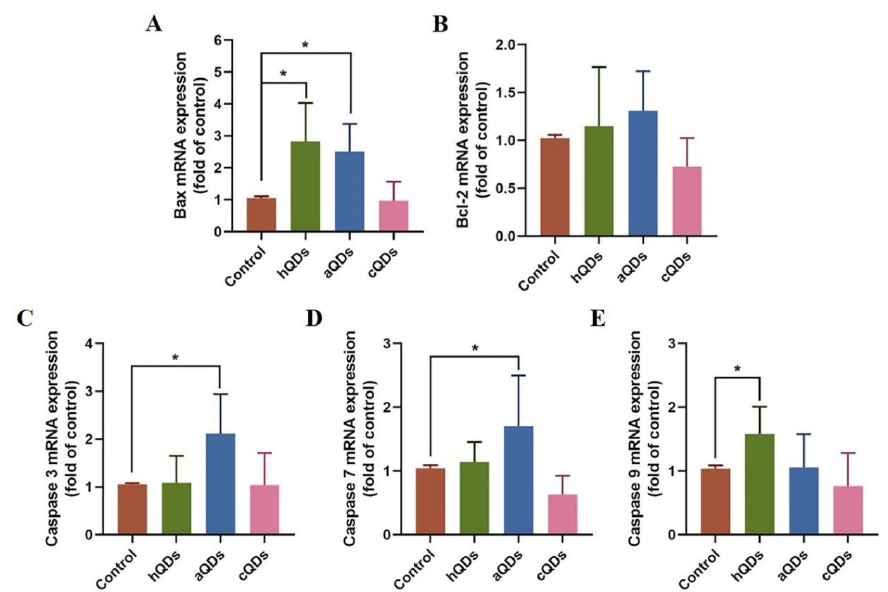
Figure 8. The mRNA levels of apoptosis-related genes in mouse kidney on Day 1 after being administered with 25 mg / kg BW QDs. ( A ) Bax mRNA levels. ( B ) Bcl-2 mRNA levels. ( C ) Caspase 3 mRNA levels. ( D ) Caspase 7 mRNA levels. ( E ) Caspase 9 mRNA levels. (* Significantly di ff erent compared to control group, p <